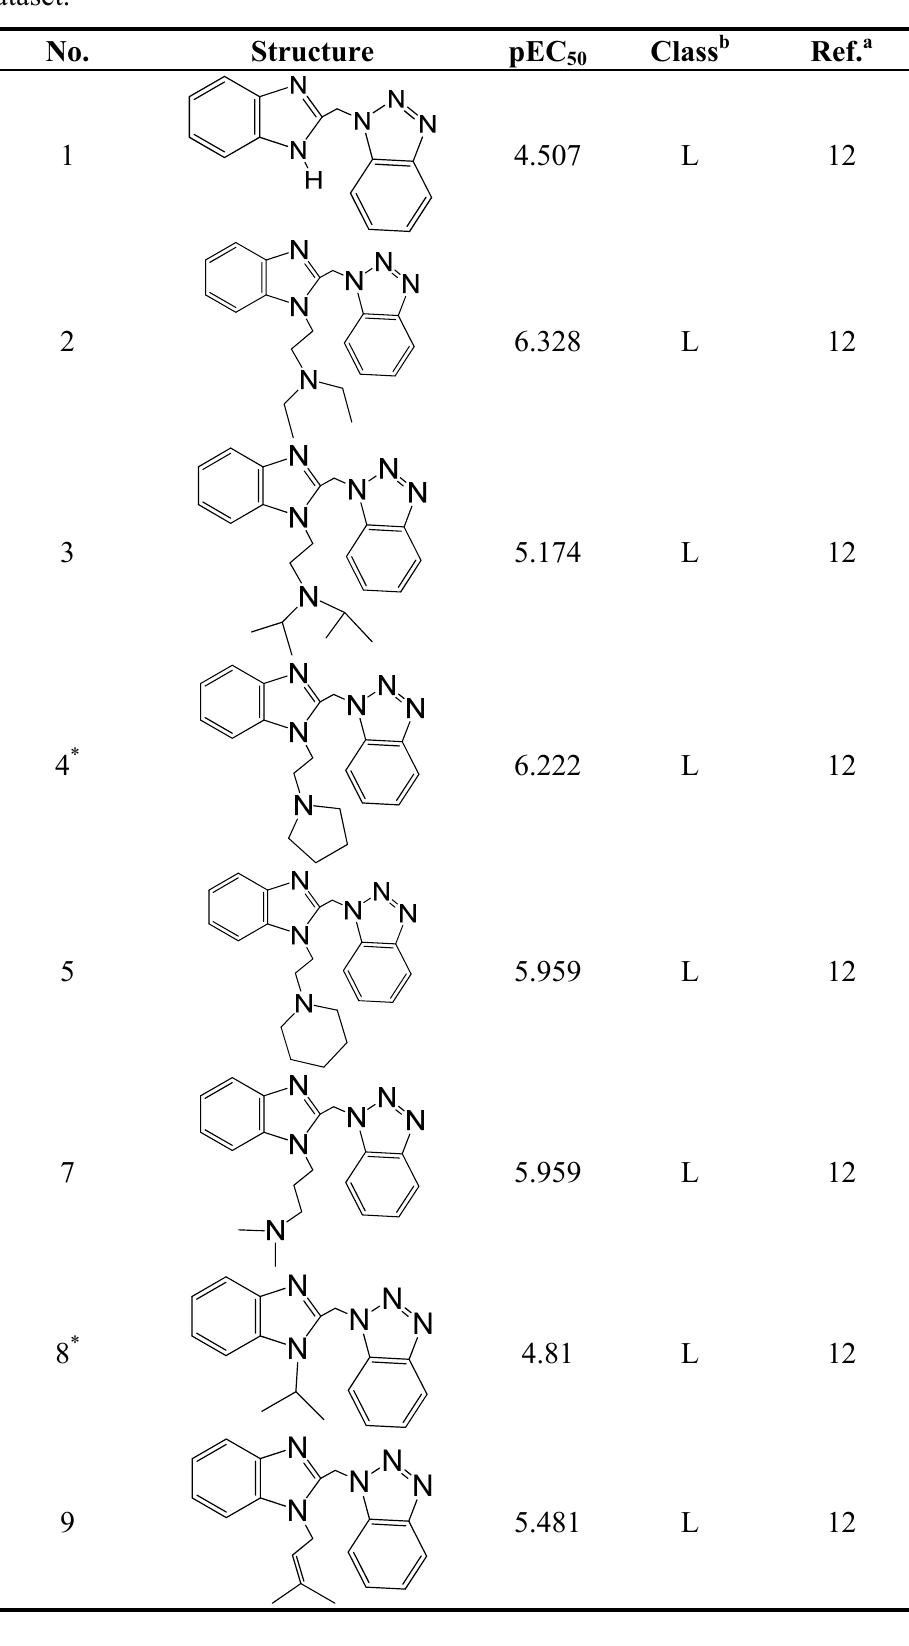
Table 4. Representative compounds with their chemical names, activities and classes used in the